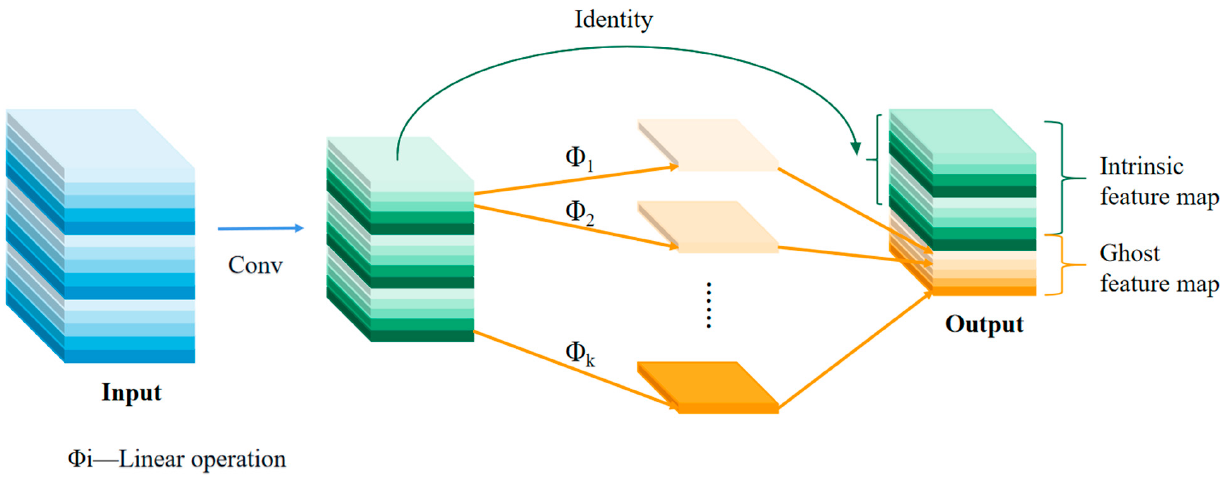
Figure 2. GhostNet Figure 2. GhostNet Module.